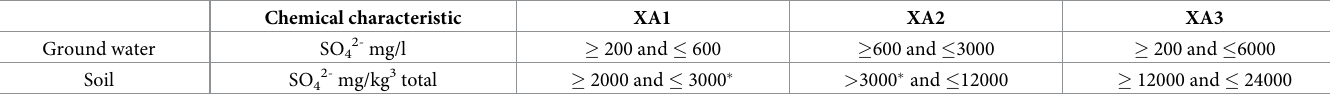
Table 1. Exposure classes XA and limiting values for exposure classes for chemical attack from natural soil and